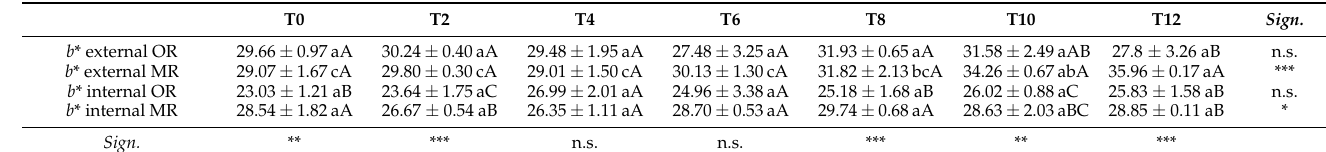
Table 3. Colours and b * values of Cantuccini biscuits made using the original recipe (OR; 50% cow’s butter/50% margarine) and modified recipe (MR; 70% EVOO/30% cow’s butter). One-way ANOVA, means ± SD (of six replicates) in the same row followed by a different letter are significantly different according to Tukey’s test; n.s., not significant; ** p < 0.01; *** p < 0.001. Means in the same column are distinguished by capital letters. Means in the same line are distinguished by small letters.